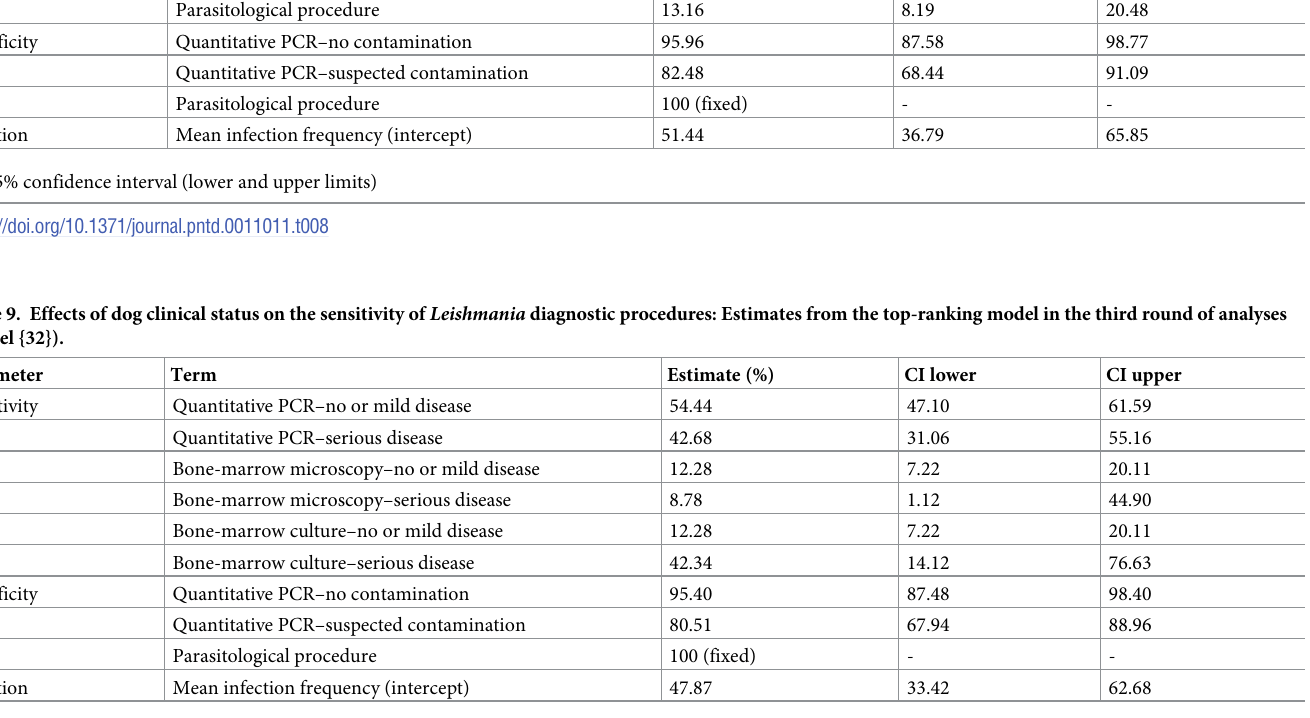
Table 8. Effects of suspected plate contamination on the specificity of quantitative PCR (qPCR) assays for the detection of Leishmania in dogs: Estimates from the top-ranking model in the second round of analyses (model {13}). Parameter Sensitivity